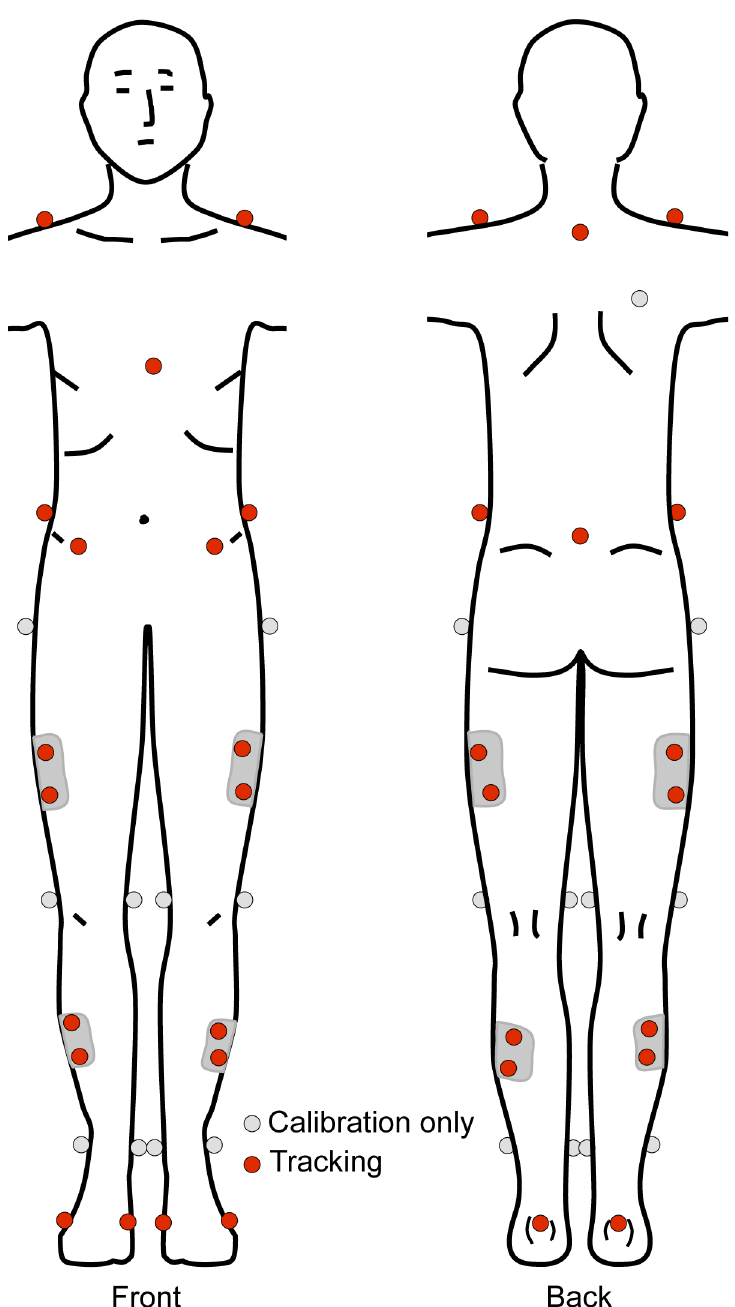
Fig 1. Representation of the 42 spherical, retro-reflective markers placed bilaterally over landmarks on the lower extremity, pelvis and trunk.